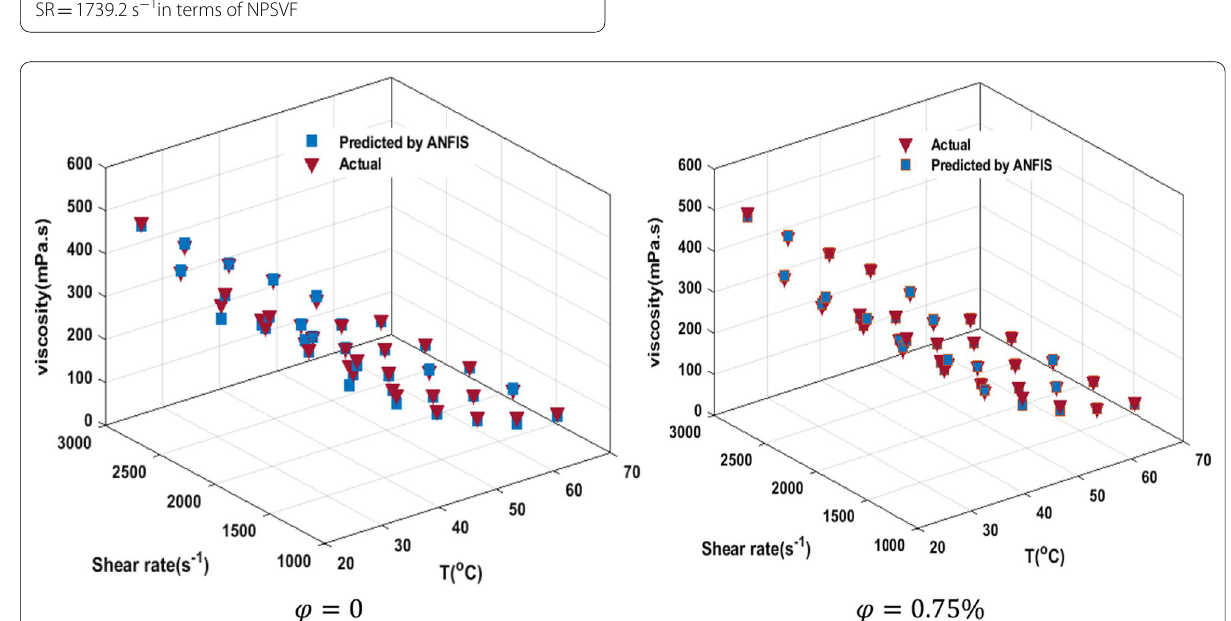
Fig. 18 Comparison of estimated data by ANFIS model with experimental data